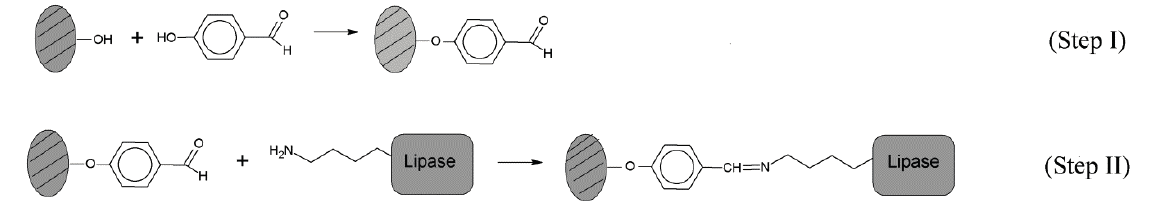
Figure 1. General scheme for the immobilization of the enzyme through the ε -amino activation is performed by microwave, heated groups of lysine residues. Amorphous AlPO 4 with p-hydroxybenzaldehyde ( Step 1 ) before to the covalent immobilization of the enzyme through lysine residues ( Step 2